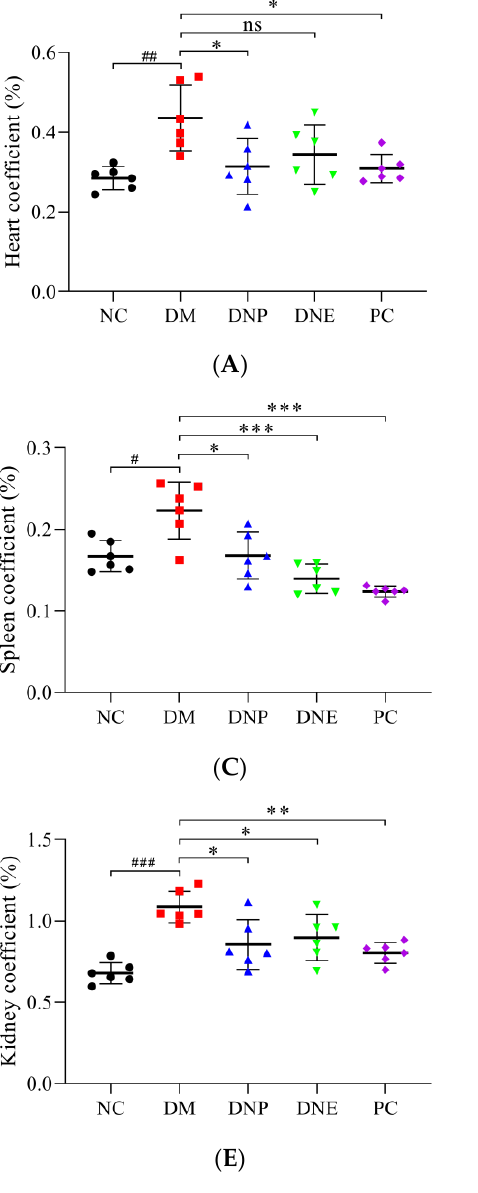
Figure 12. Effects of D. nobile on organ coefficients (( A ): heart, ( B ): liver, ( C ): spleen, ( D ): lung, ( E ): kidney and ( F ): pancreas) of T2DM rats. All data are expressed as mean ± S.D. (n = 6 per group). Compared with the NC group, # p < 0.05, ## p < 0.01, and ### p < 0.001; compared with the DM group, * p < 0.05, ** p < 0.01, and *** p < 0.001.